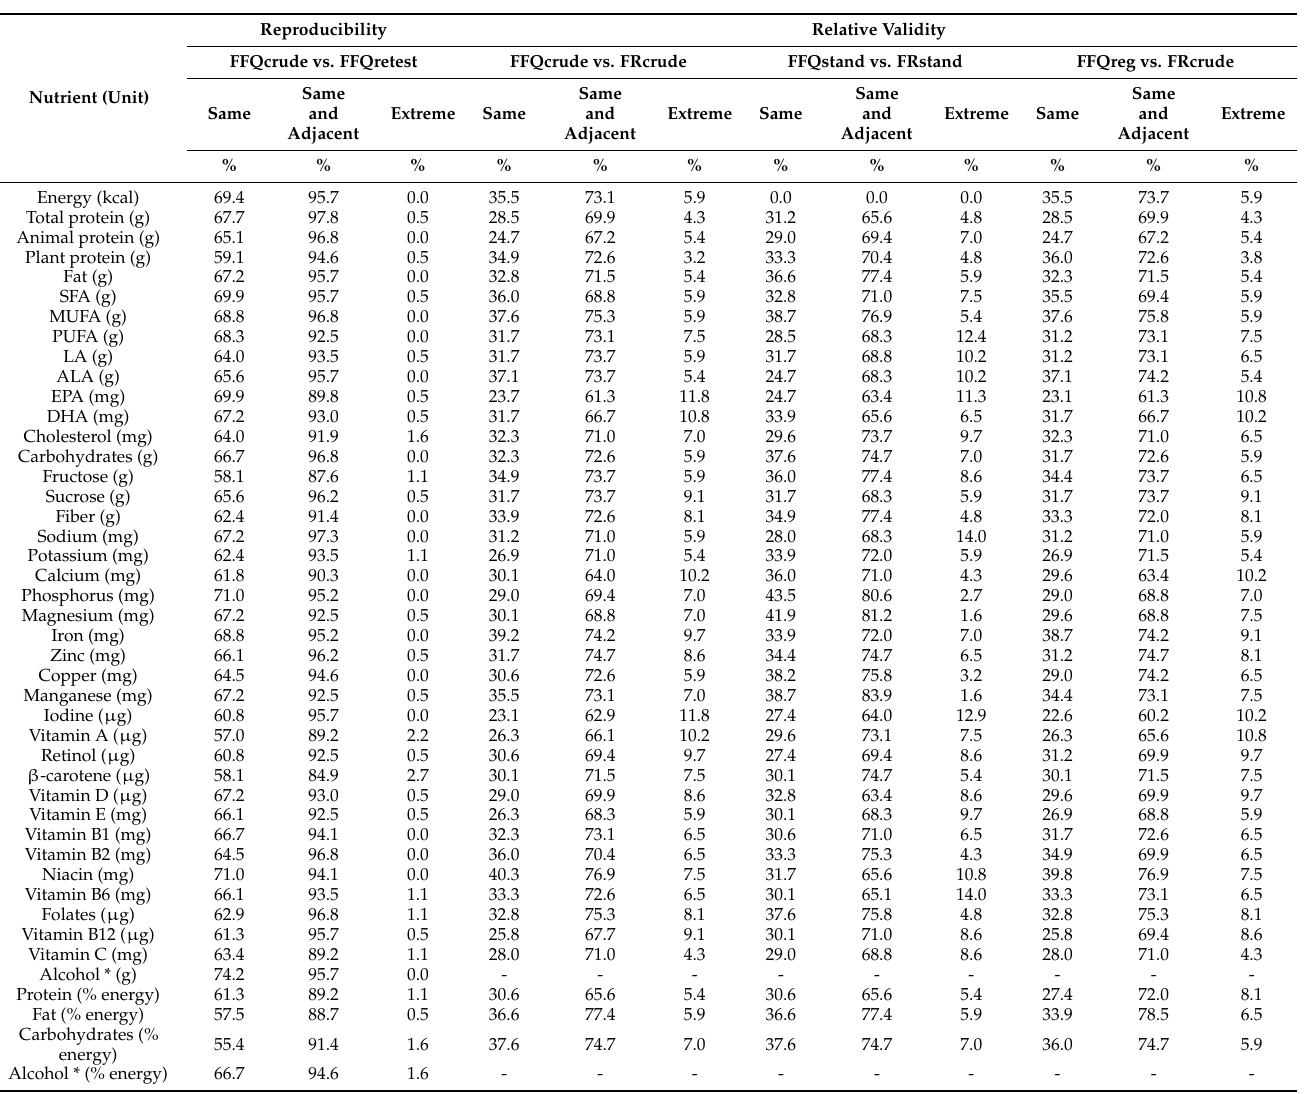
Table 4. Cross-classification of quartiles of energy and nutrient intake obtained with the 72-item SQ-FFQ and estimated food record (FR) among Polish young adults ( n =